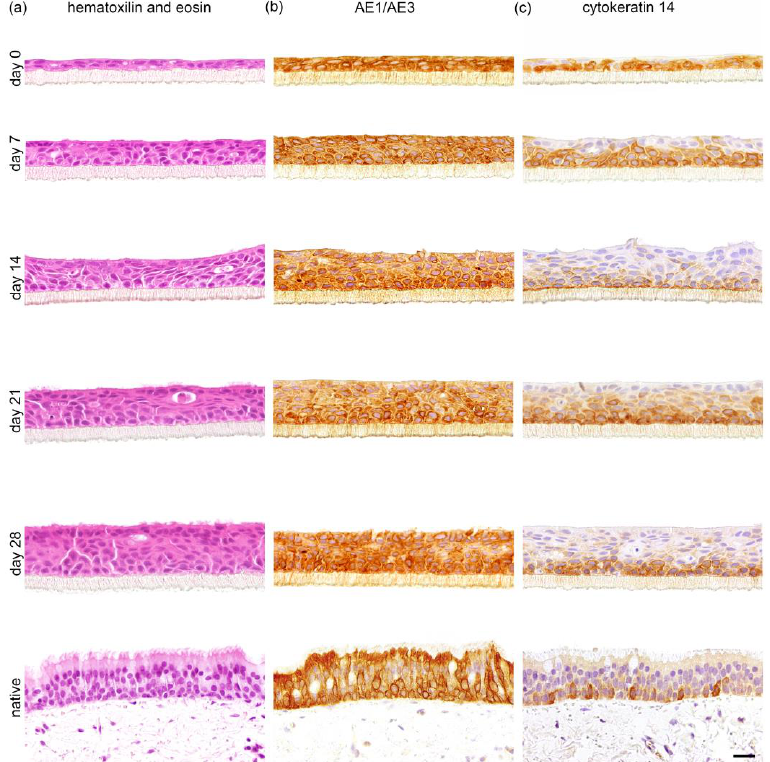
Figure 1. Histological evaluation of tracheal epithelial air – liquid interface (ALI) cultures during a four-week observation period. Primary tracheal epithelial cells were cultured for the indicated number of days (left labeling), then formalin-fixed and paraffin-embedded using standardized protocols. Sections were stained using ( a ) hematoxylin and eosin for evaluation of general cellular morphology, immunohistochemistry with ( b ) pan-cytokeratin (AE1/AE3) to visualize the epithelial cytoskeleton and ( c ) cytokeratin 14 to determine the expression of basal cells. Scale bar represents 20 µ